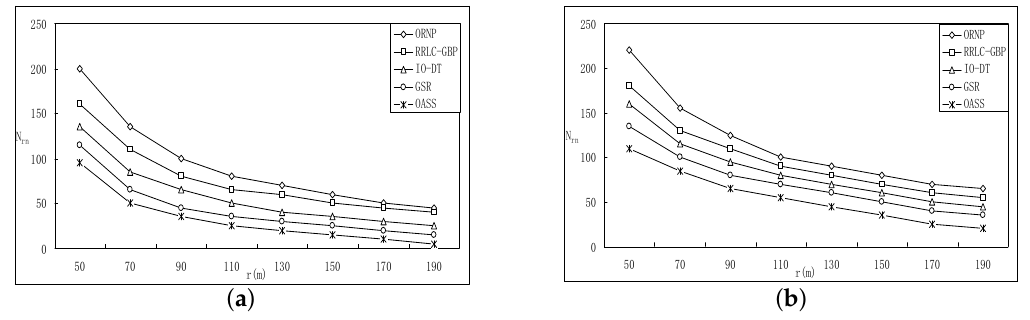
Figure 6. The effect of varying r on the performance of OASS compared with all baseline approaches w.r.t. ( a ) when N c = 4; ( b ) when N c = 6.